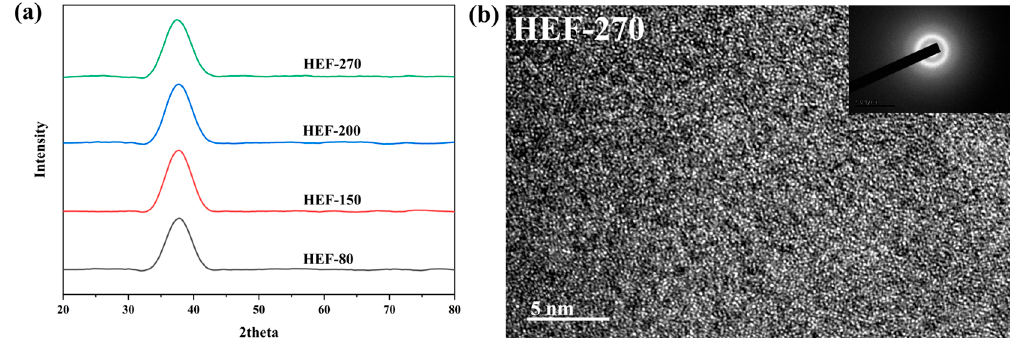
Figure 9. ( a ) Comparison of XRD patterns of as ‐ cast and hot ‐ compressed elastic deformation (HEF) ‐ treated samples, and ( b ) TEM image of HEF ‐ 270 treated sample.